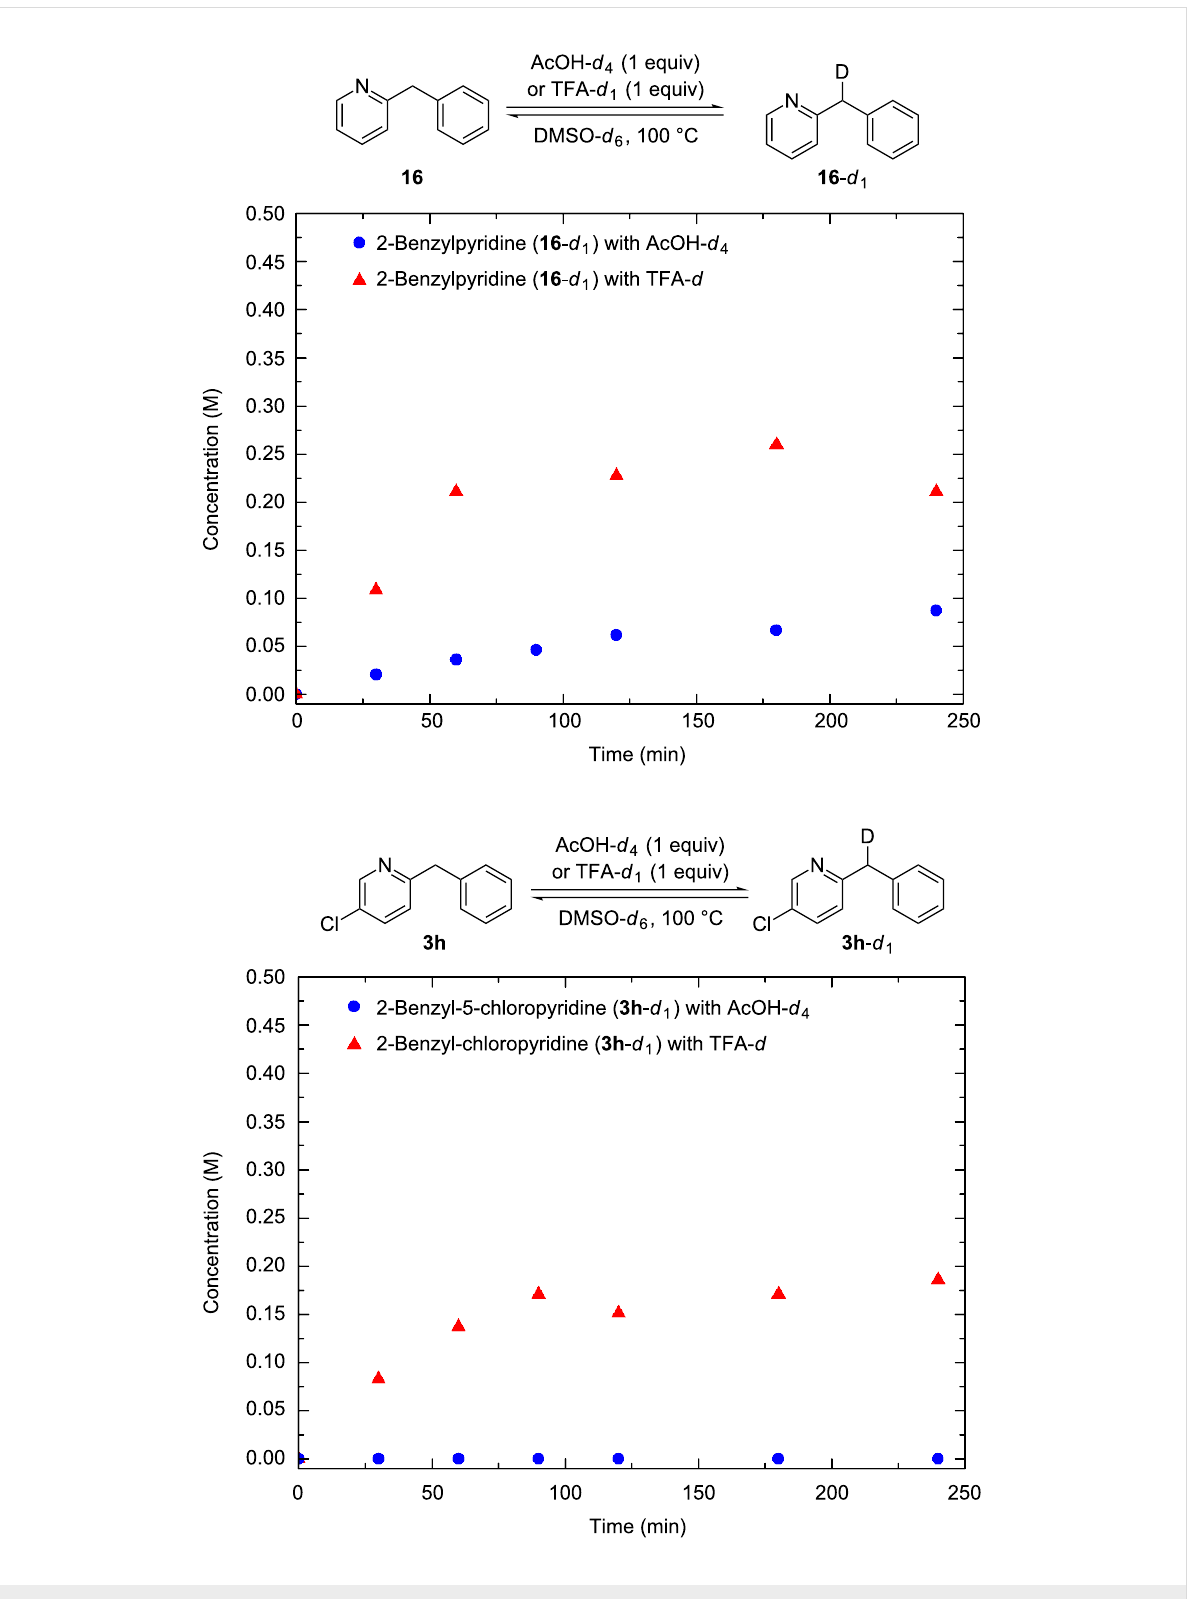
Figure 1: Hydrogen–deuterium exchange through acid-catalyzed imine–enamine tautomerization of 3h (0.5 M) and 16 (0.5 M) using AcOH- d 4 (0.5 M) or TFA- d 1 (0.5 M). 1 H NMR spectroscopy was used to quantify the monodeuterated